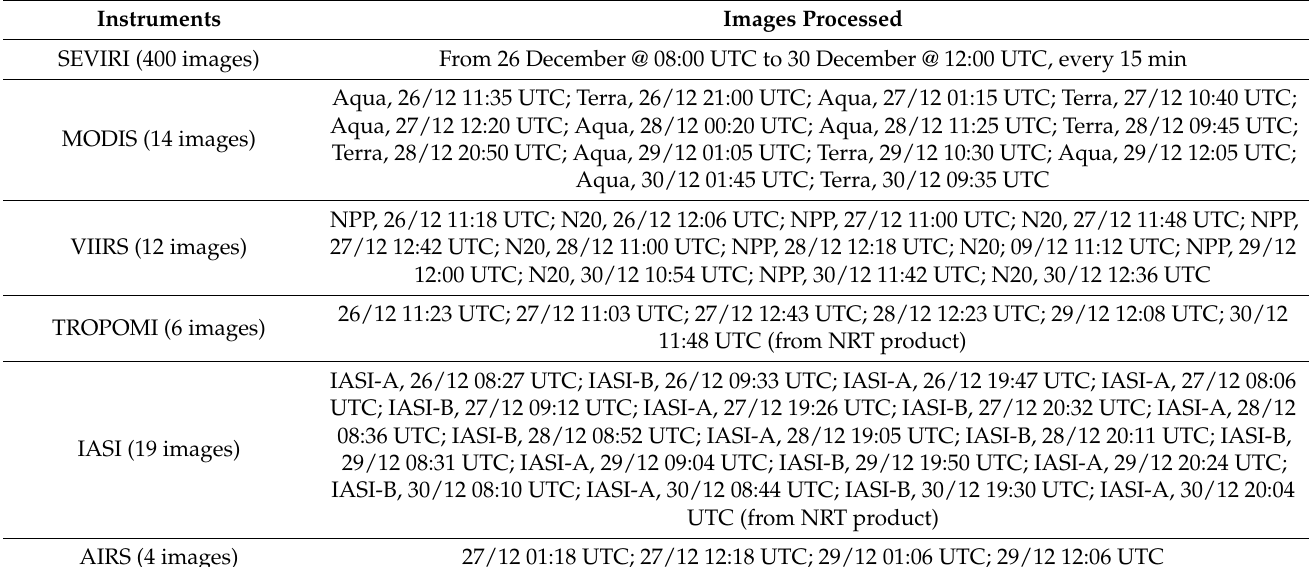
Table 2. List of GEO and LEO satellite data processed for the cross-comparison exercise. Note that TROPOMI and IASI are both operational products.